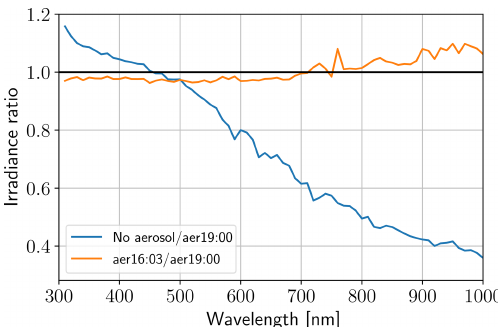
Figure 13. Simulated irradiance during totality (17:20:00UTC) for different wavelengths, relative to irradiance with the Ångström pa- rameters derived at 19:00UTC. For the blue curve, no aerosol was specified, for the orange curve aerosol was parameterized with the Ångström parameters derived at